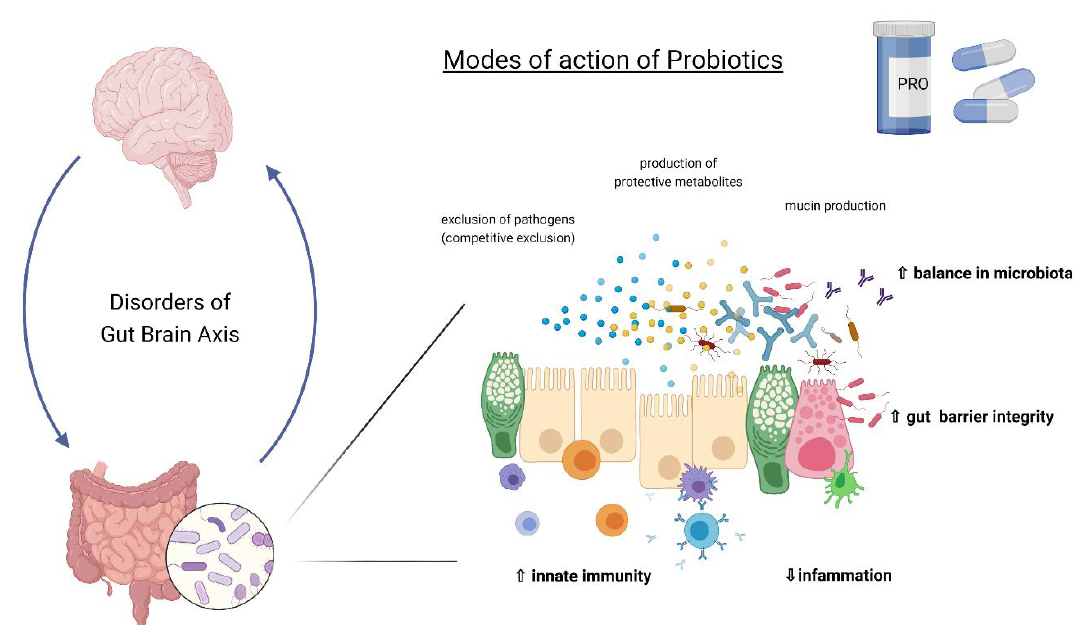
Figure 1. General mechanism of action of